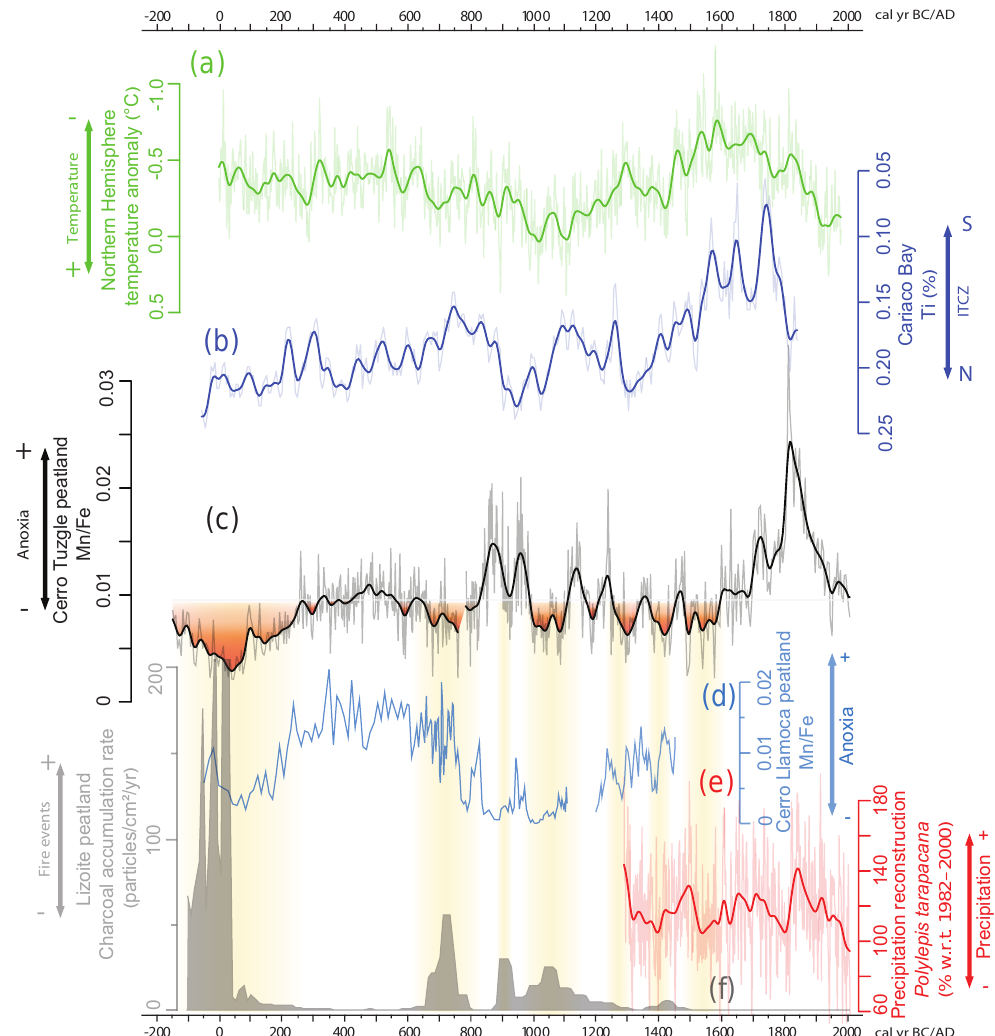
Figure 6. The late Holocene Mn / Fe ratio sequence of Cerro Tuzgle peatland compared with regional and supra-regional records. Panel (a) : Northern Hemisphere temperature reconstruction (Moberg et al., 2005). Panel (b) : bulk Ti content of Cariaco Basin sediments (Haug et al., 2001). Panel (c) : Mn / Fe ratio sequence of CTP. Drier-than-average conditions are shown in orange. Panel (d) : Mn / Fe ratio sequence of Cerro Llamoca peatland (Schittek et al., 2015). Panel (e) : precipitation reconstruction for the Central Andes based on Polylepis tarapacana tree rings (Morales et al., 2012). Panel (f) : Lizoite peatland charcoal accumulation rates (Schittek,